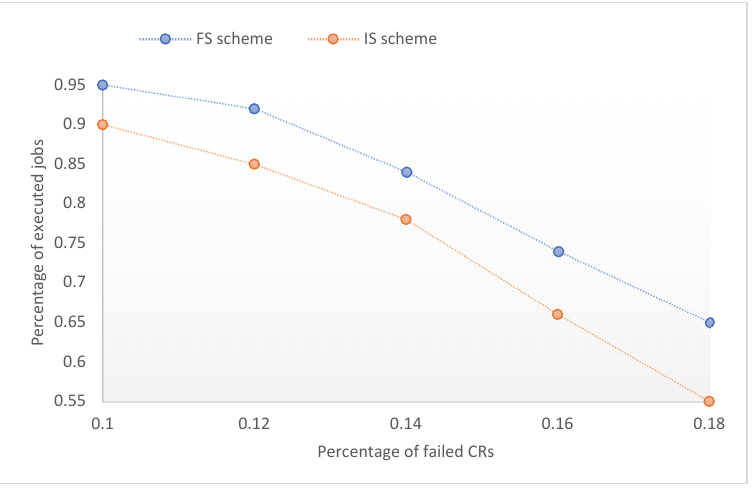
Figure 2. Percentage of executed jobs under different percentage of failed CRs.